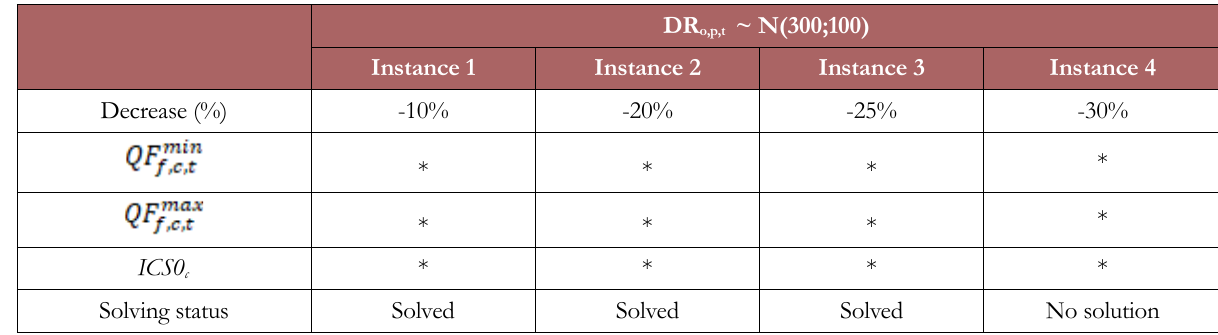
Table 10. Parameters change and solving